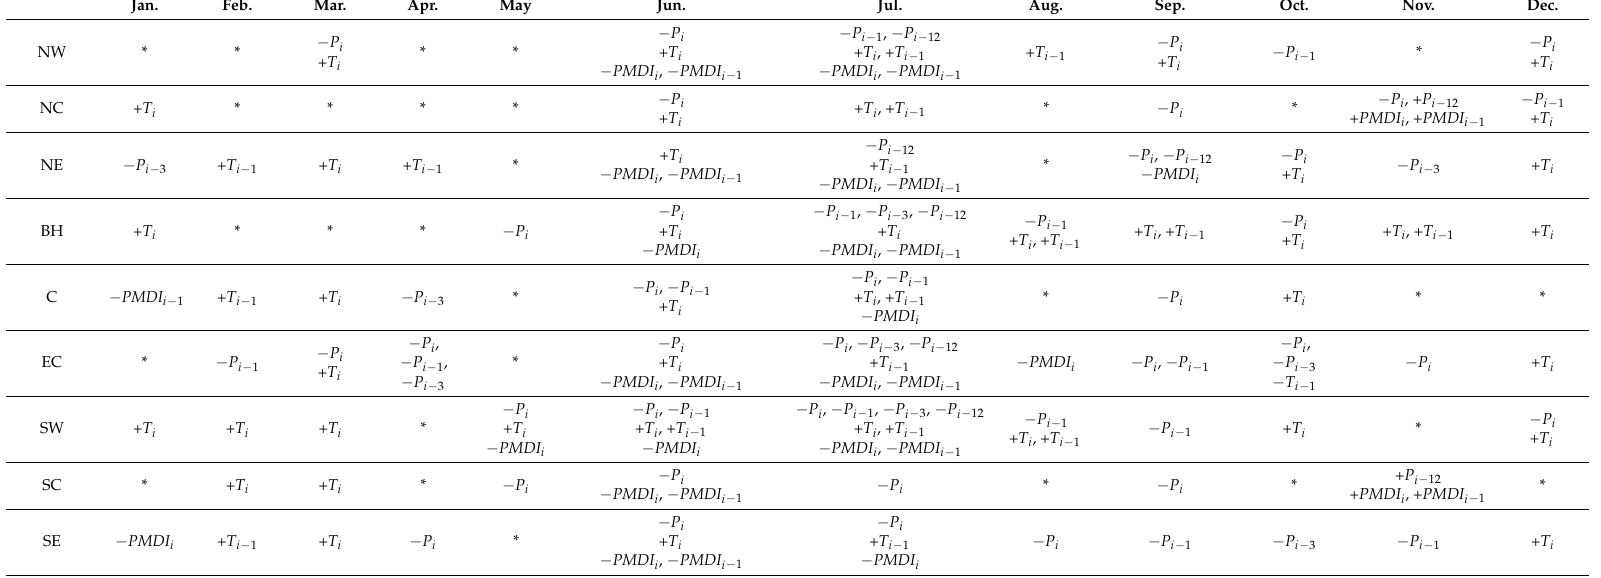
Table 3. Significant ( p < 0.05) Spearman’s rank order correlations for wildfire ignitions and climate variable pairs for each month for each South Dakota Climate Division. Positive (negative) values for PMDI indicate significant rank correlations between abnormally wet (dry) periods and the number of ignitions, positive (negative) values of temperature (T) indicate significant rank correlations between above (below) average temperatures and the number of ignitions, and positive (negative) values of precipitation (P) indicate significant rank correlations between precipitation deficits (surpluses) and the number of ignitions. Asterisks (*) imply no significant correlation. See text and Table 1 for climate variable and subscript time-lag